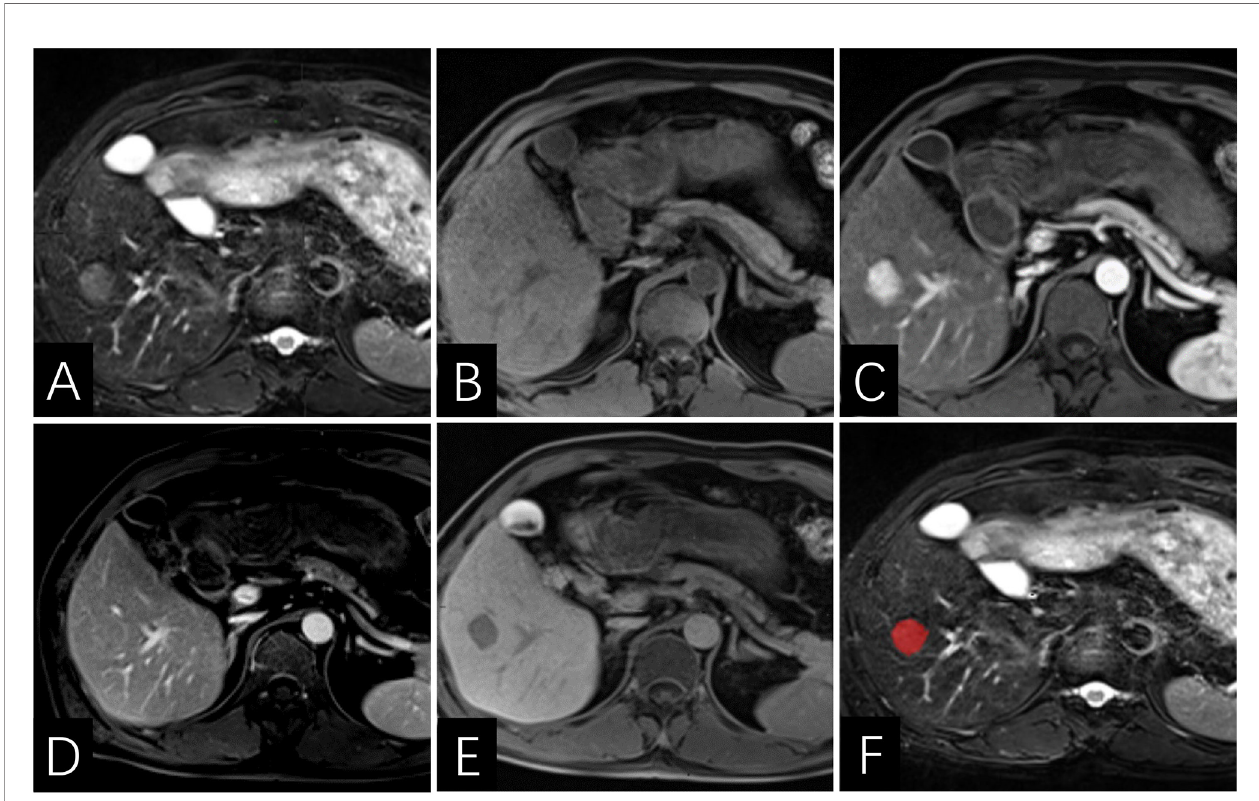
FIGURE 5 | Images of a 46-year-old man with HCC without early recurrence. (A – E) the tumor demonstrates lack of enhancing capsule with hepatobiliary phase hypointensity. (F) the lesion was fi rst ROI segmented in red and the ROI was plotted on each cross section of the entire lesion to get the texture information. The Rad-score of this patient was -6.7, and his PLT was 209×10 3 /ml. According to the Nomogram, his total point was about 44, indicating the risk of ER was more than 0.1 but less than